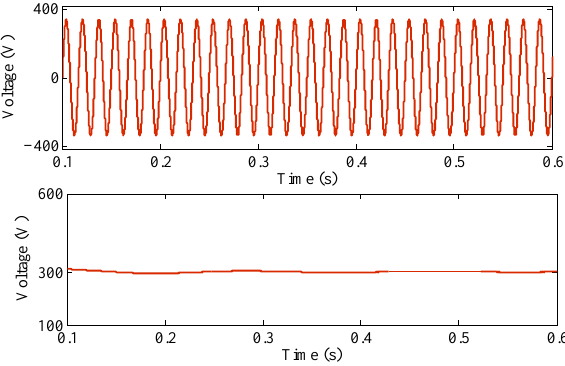
Figure 14. Grid voltage ( top ) and output voltage of the bidirectional converter in rectification mode ( bottom